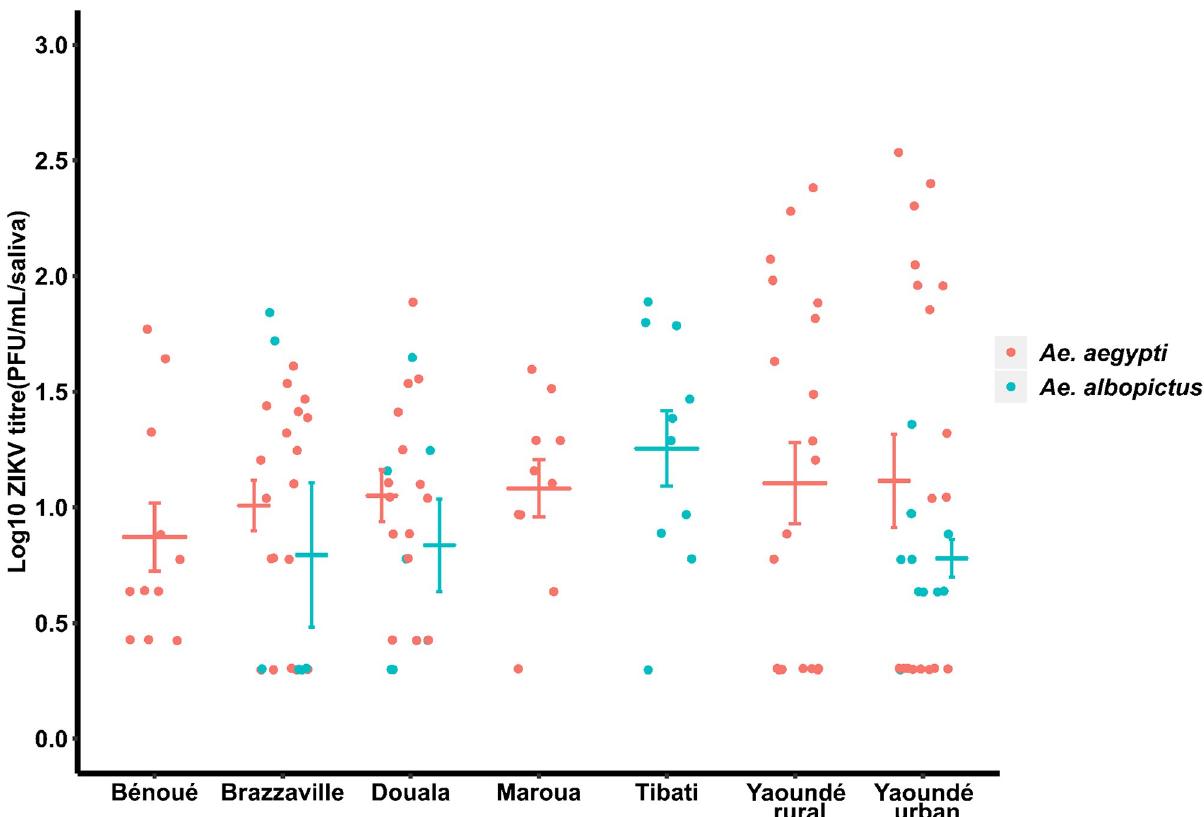
Fig 4. Zika virus titres in saliva of Ae . aegypti and Ae . albopictus at 21 days post-exposure. The bars indicate the confidence interval of the mean for viral load in each population.